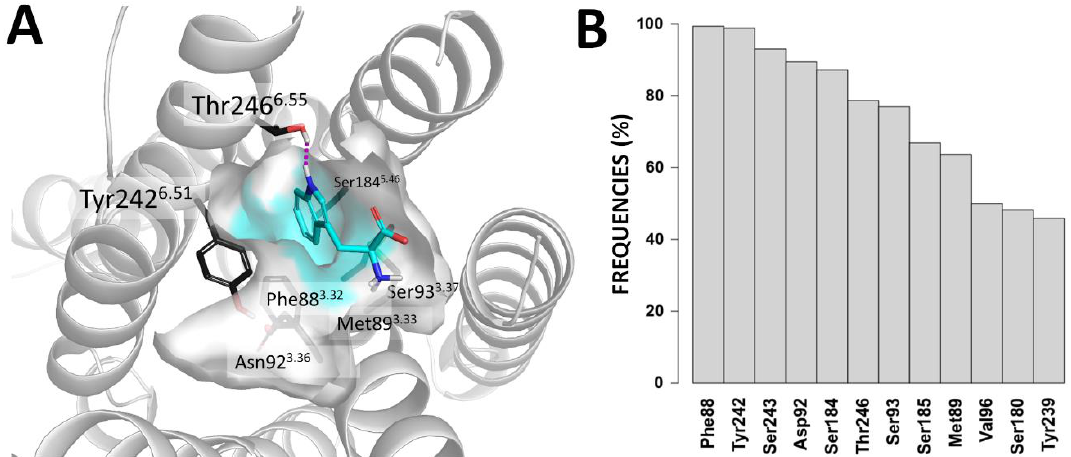
Figure 3. ( A ) Docking pose of the tryptophan within TAS2R4 epitope 1. The surface of the epitope is colored in cyan. Residues involved in shaping the epitope are shown as dark grey sticks. Tryptophan is represented as cyan sticks. The H-bond between the ligand and Thr246 6.55 is shown as a magenta dashed line. ( B ) Frequencies of the contacts between the tryptophan with TAS2R4 residues during the MD simulation.